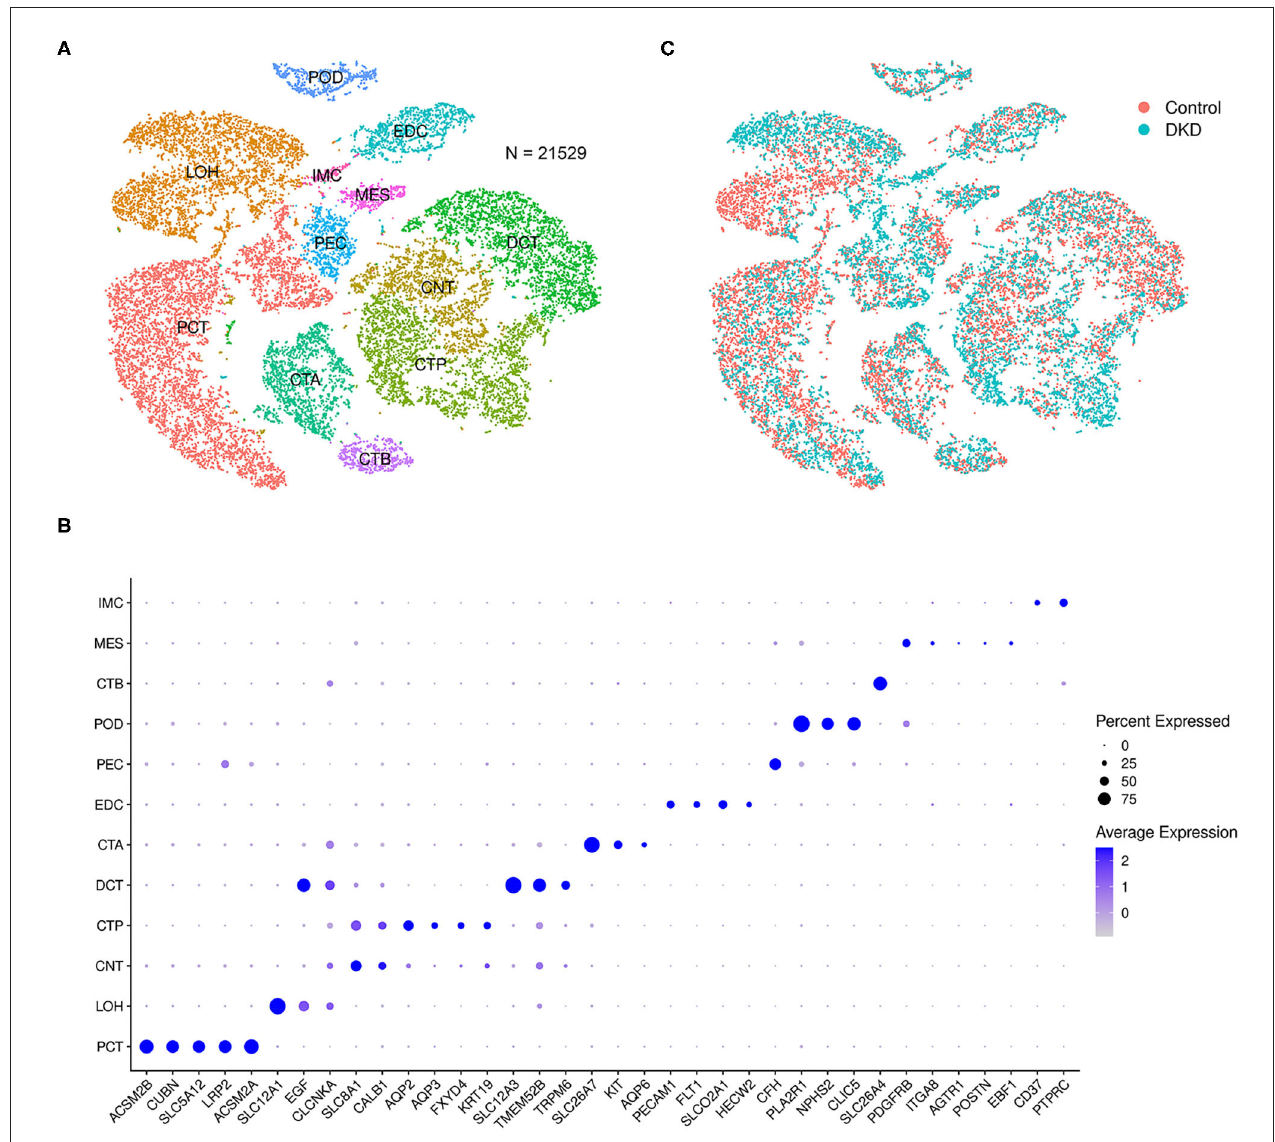
FIGURE 1 | Integrated snRNA-seq of nondiabetic and diabetic kidneys. We performed t-SNE analysis (A) , identified gene markers (B) , and determined the distributions (C) of the 21,529 nuclei. Proximal tubular convoluted cells (PCT), cells of the loop of Henle (LOH), connecting tubule cells (CNT), principal cells of the collecting duct (CTP), distal convoluted duct cells (DCT), intercalated cell A from the collecting duct (CTA), glomerular endothelial cells (EDC), parietal epithelial cells (PEC), podocytes (POD), intercalated cell B from the collecting duct (CTB), mesangial cells (MES), and immune cells (IMC) were manually